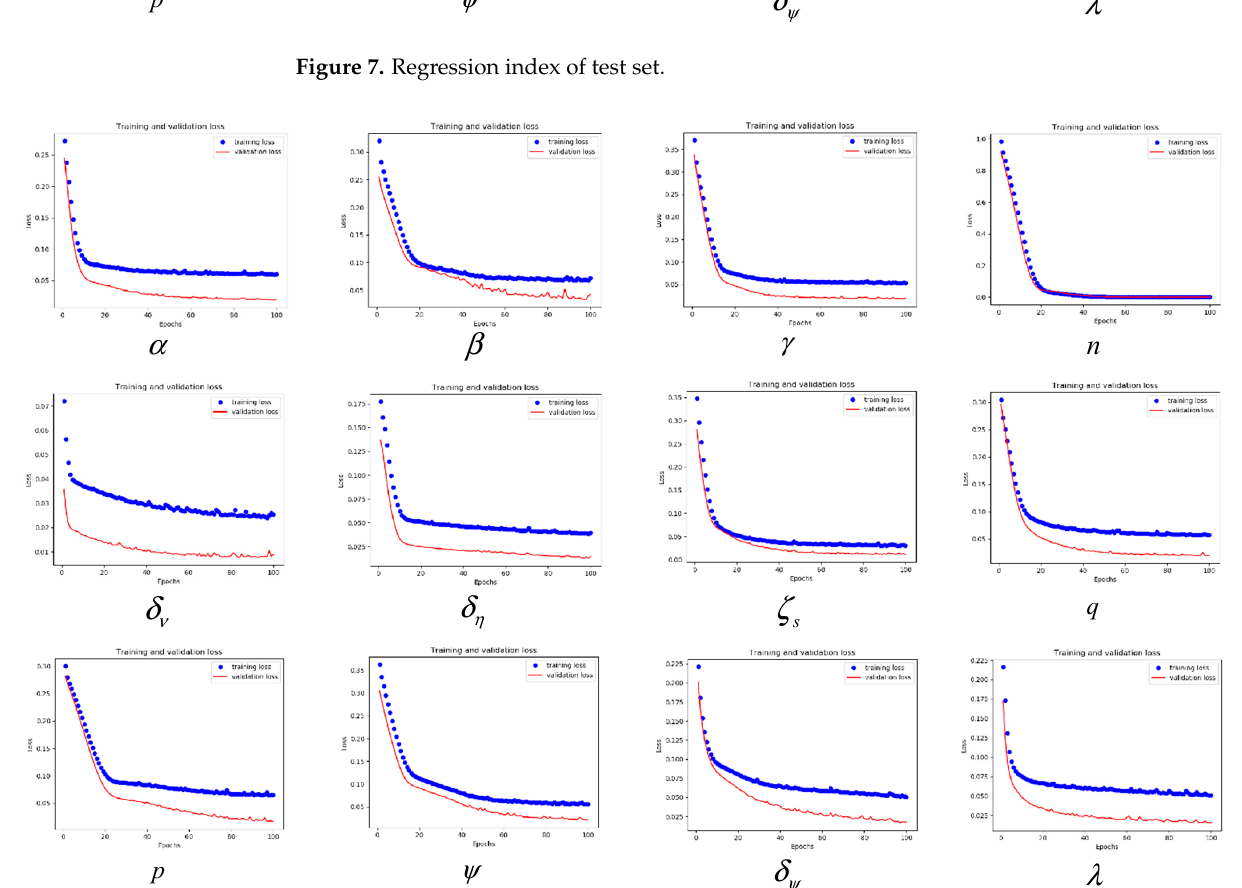
Figure 8. Loss of train set and test set.